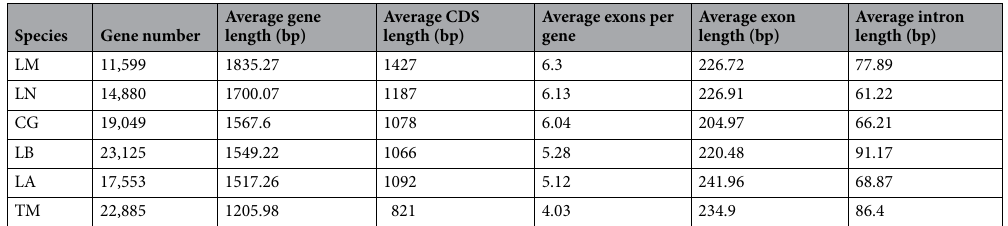
Table 2. Statistics of the genomes of LM and other